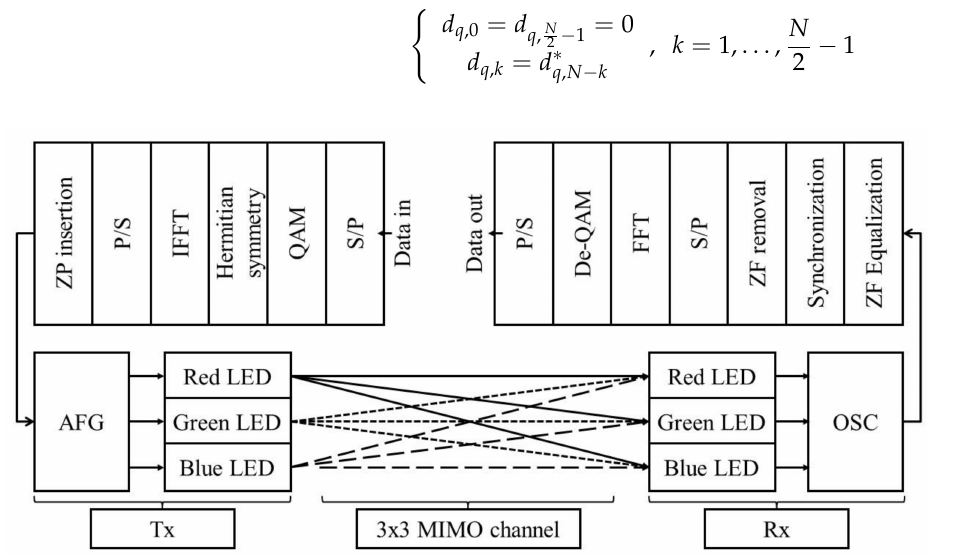
Figure 2. Block diagram of the 3 × 3 MIMO LED-to-LED communication